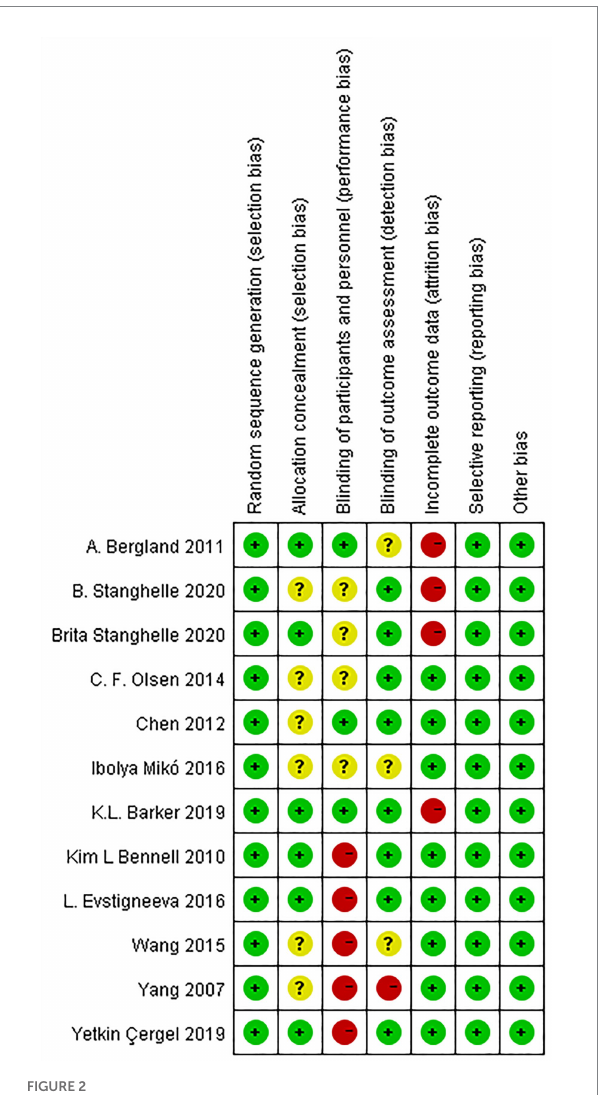
FIGURE 2 Risk of bias assessment summary of RCTs.